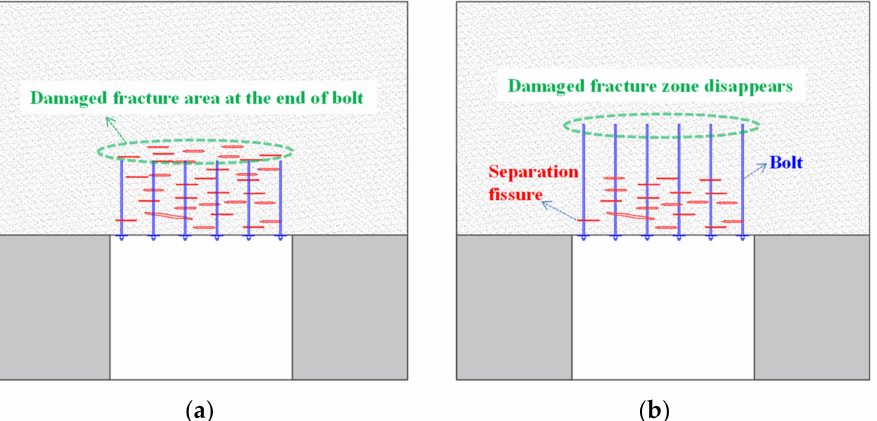
Figure 5. The separation fractures at the ends of bolts with different lengths: ( a ) short bolts; ( b ) long bolts.